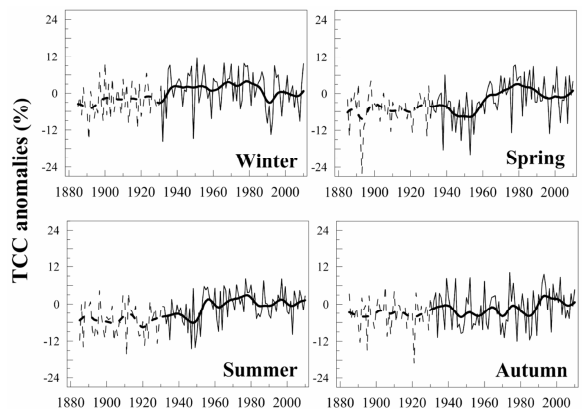
Fig. 5. Mean seasonal series (thin line) for total cloud cover (TCC) from 1885 to 2010 in Switzerland, plotted together with a 17-yr Gaussian low-pass filter (thick line). The series are expressed as anomalies from the 1981–2010 mean. Dashed lines are use before 1931 due to the lower confidence of the previous